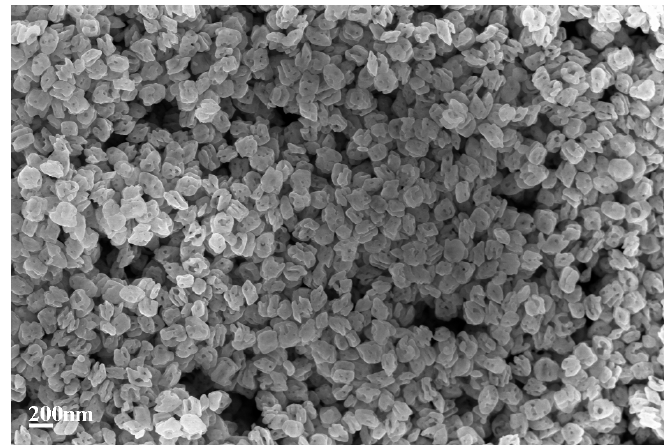
Figure 4. Scanning electron microscope (SEM) image of Ga 2 O 3 nanoparticles.